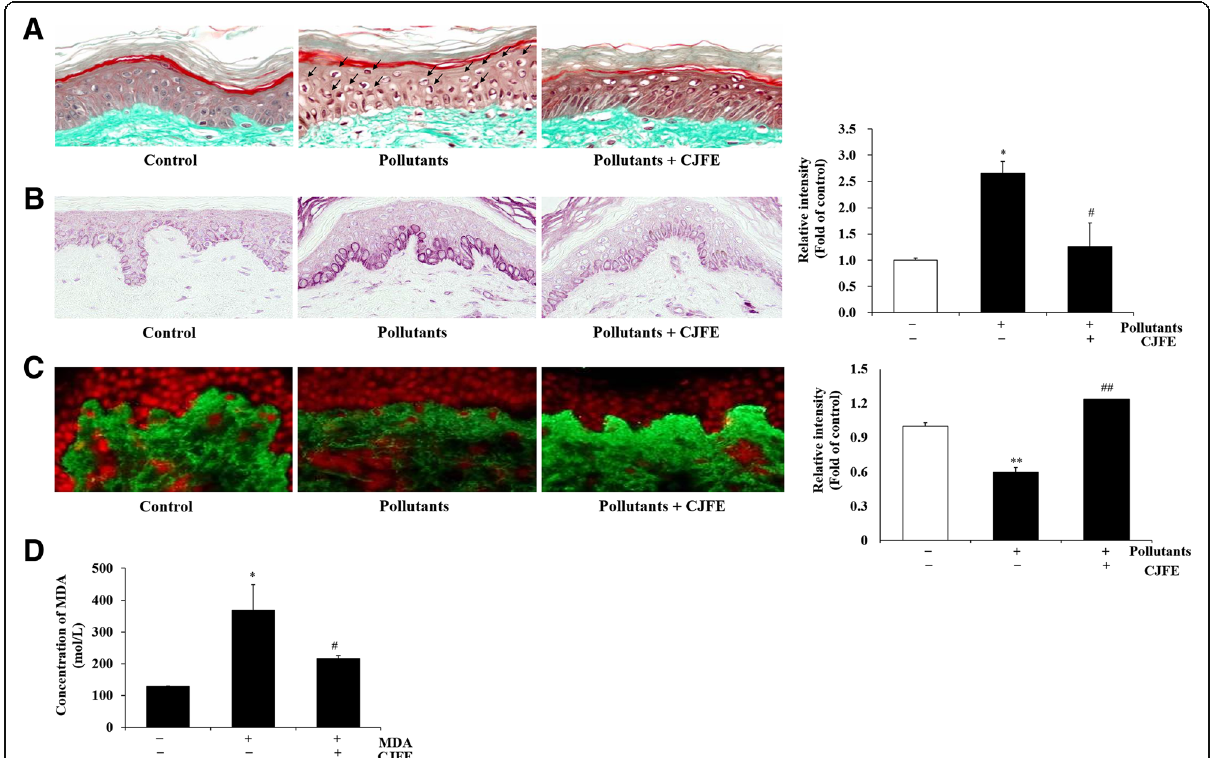
Fig. 5 The anti-aging activity of CJFE on human living skin explants exposed to pollutants. CJFE exhibited a protective effect on pyknotic nuclei condensed by pollutants as a result of morphological analysis ( a ). The expression of MMP-1 increased by pollutants was markedly decreased by treatment with CJFE ( b ), increase of Collagen I ( c ) and decrease in the level of MDA compared to the control ( d ). The results are mean ± standard deviation (SD) (n = 3). * P < 0.05, ** P < 0.01 vs. pollutant-untreated control. # P < 0.05, ## P < 0.01 vs. pollutant-treated